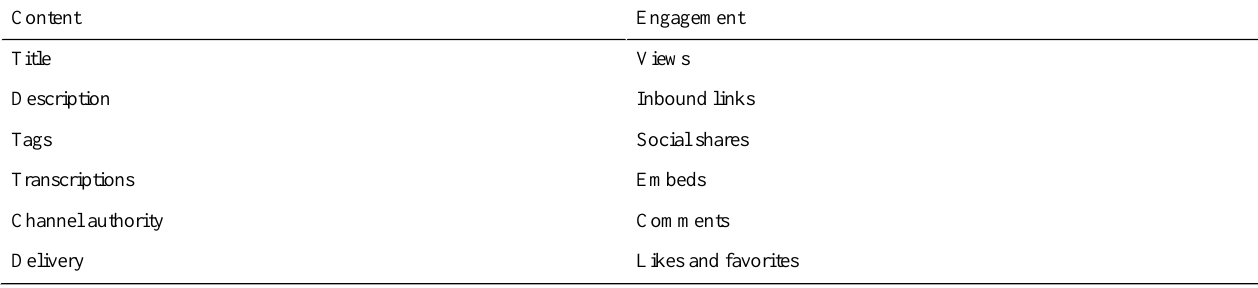
Table 5. YouTube ranking factors.